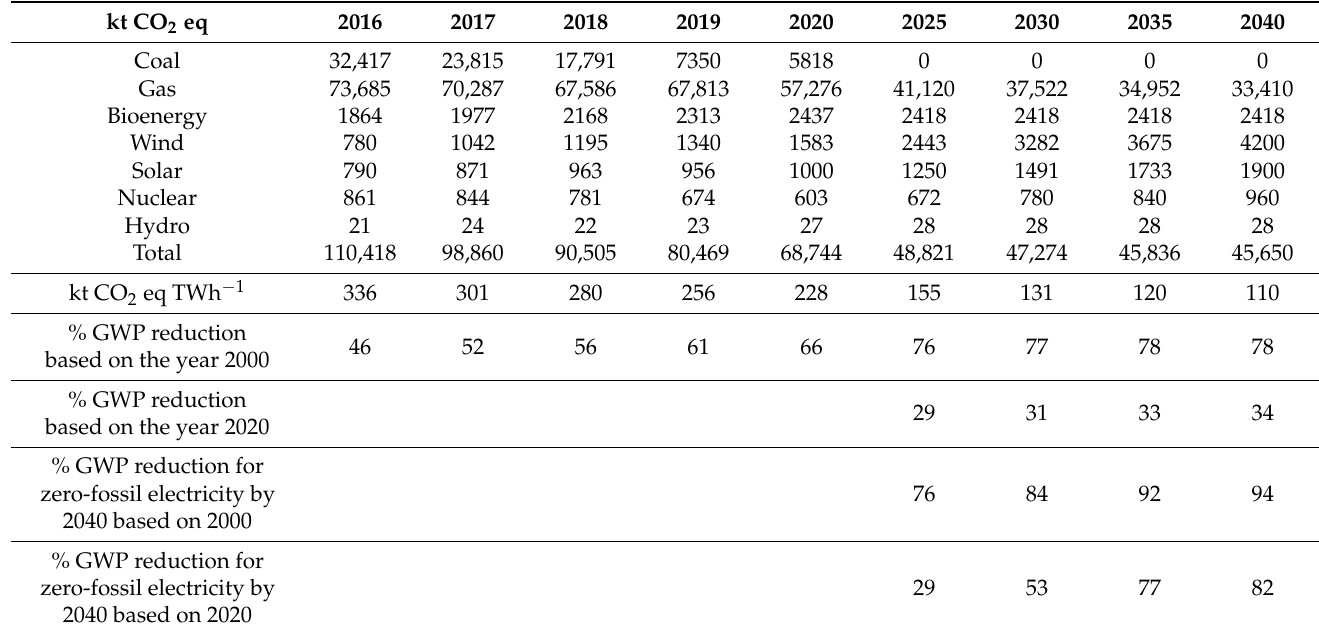
Table 5. GWP and avoided GWP by year of the UK electricity